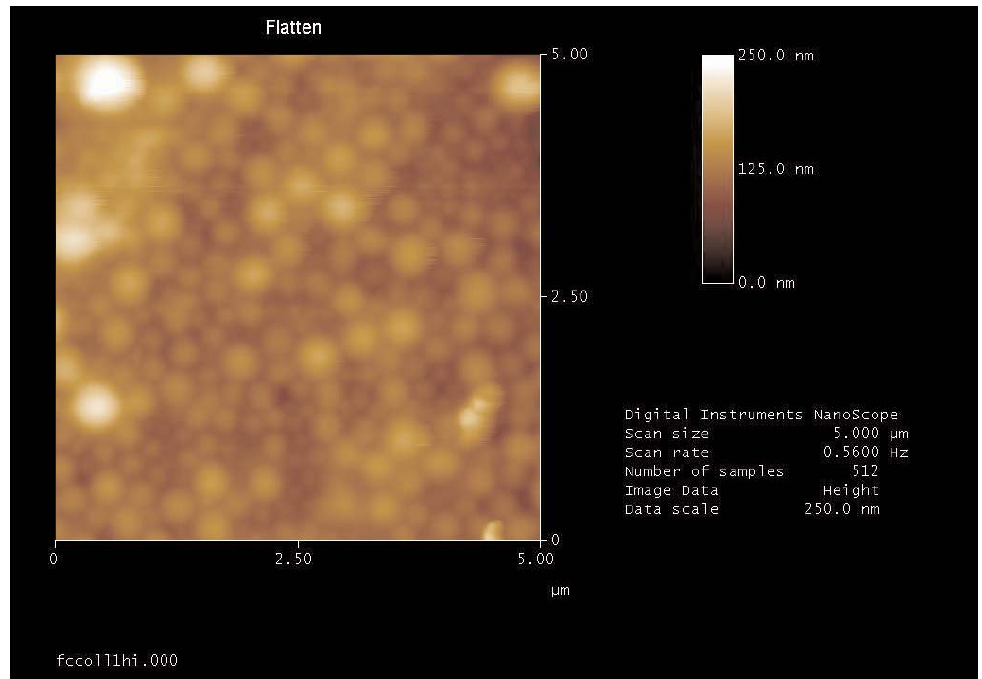
Figure 1 : Atomic force microscopy picture of cross-linked nanoparticles. 3 l of sample was placed on a mica slide, allowed to partially dry and was scanned using the tapping mode system at a scan rate of 0.5 Hz and scan size of 5 µ m. The size of the nanoparticles was in the range of 60-180 nm.